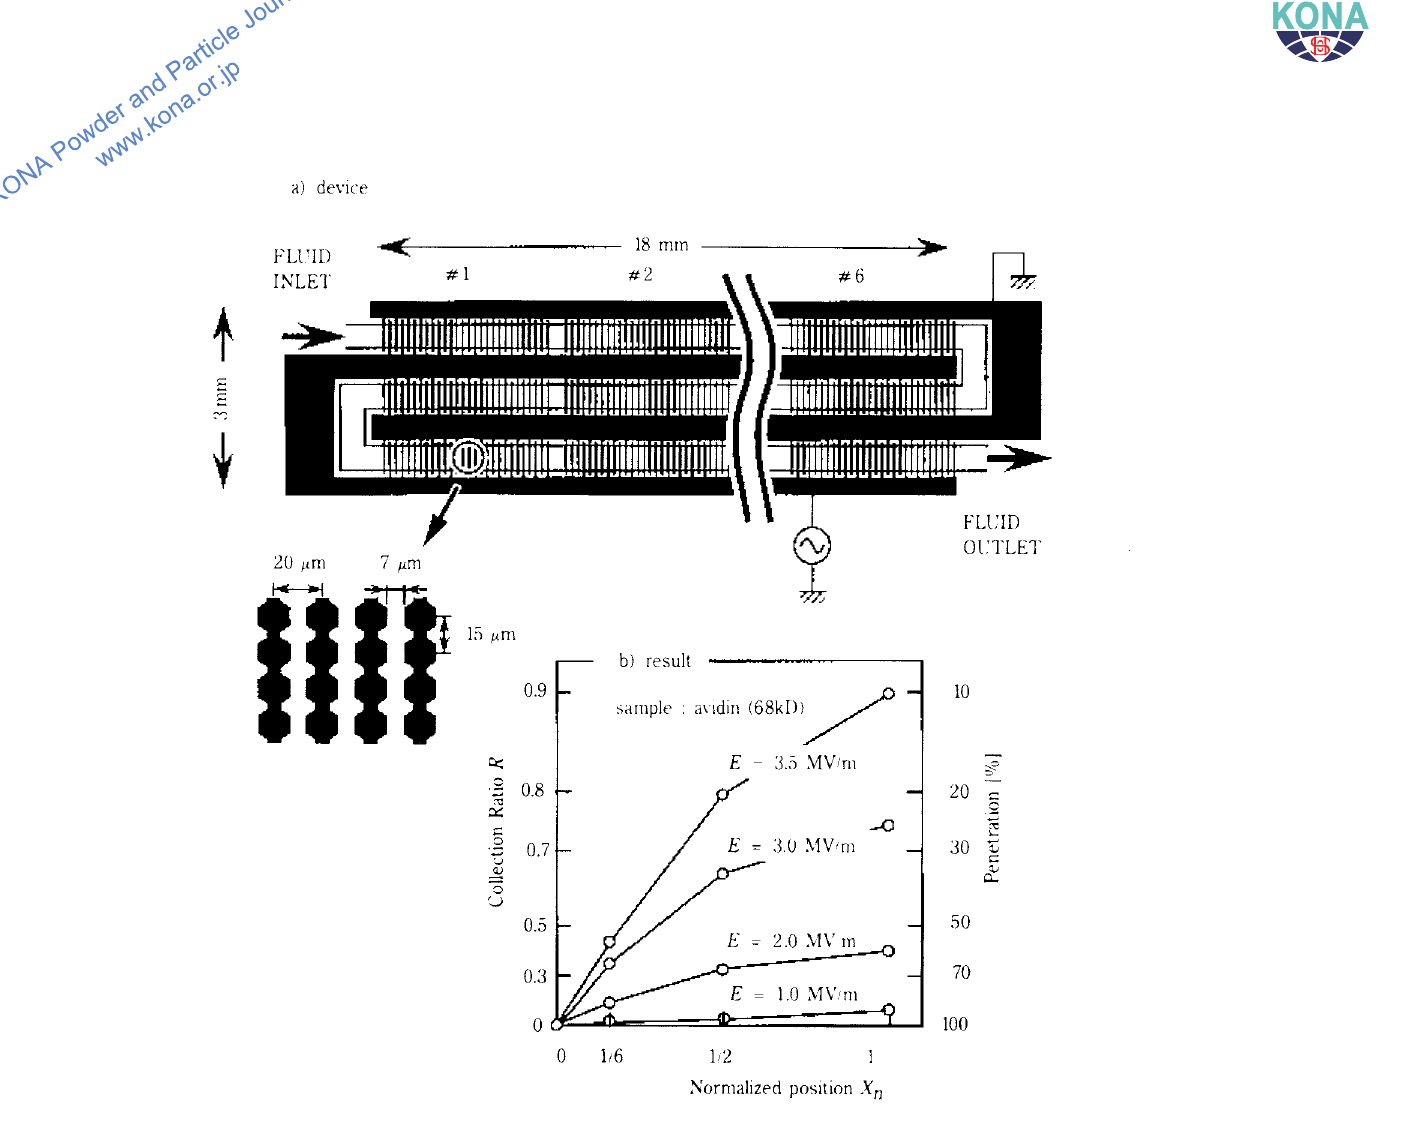
Fig. 7 Dielectrophoretic filtration of protein